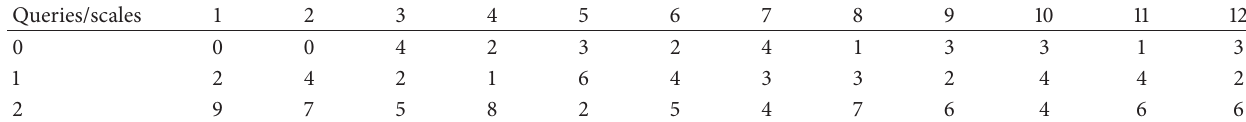
Table 4: The frequencies of all scales for each